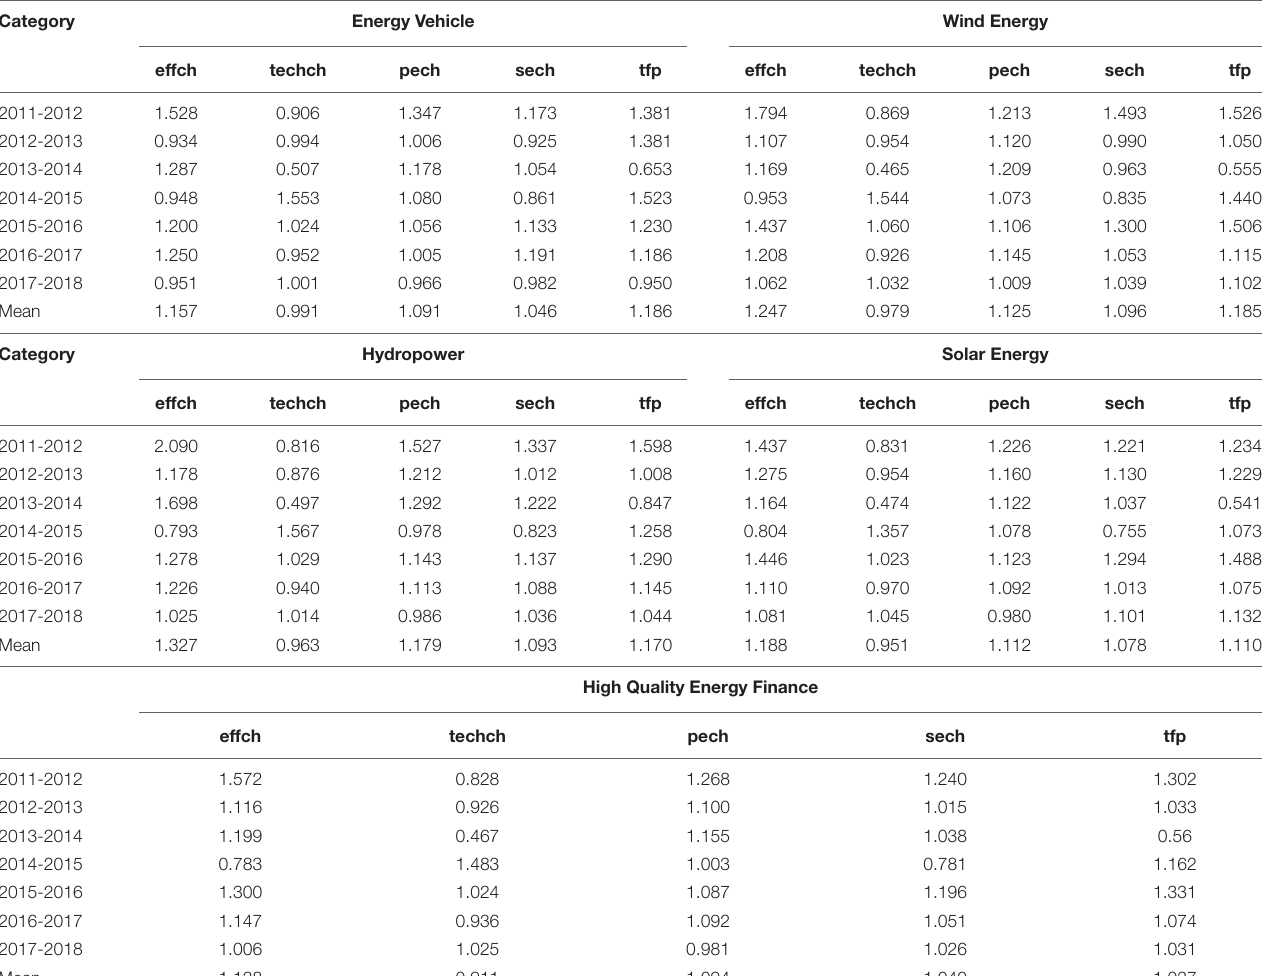
TABLE 4 | Malmquist and its decomposition of HQDEF in China from 2011 to 2018.